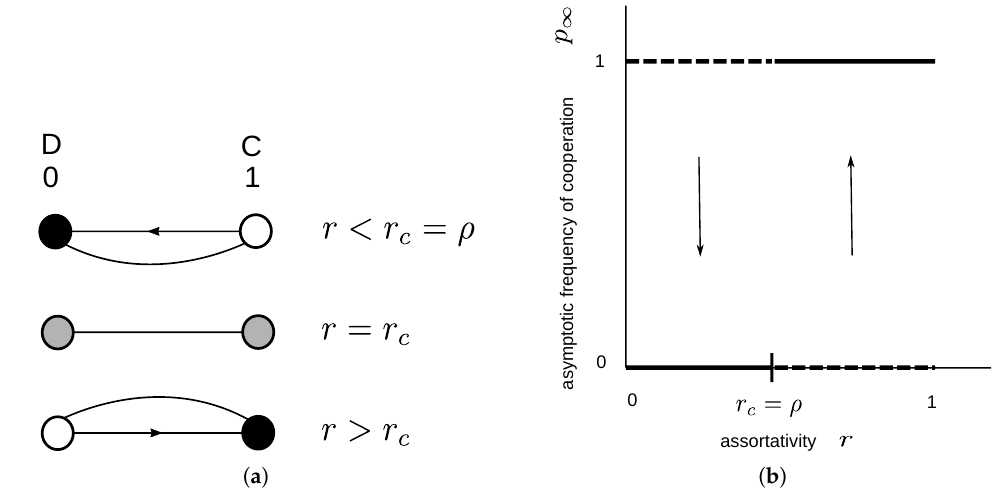
Figure 1. Phase line diagrams and the bifurcation diagram for the donation game with assortative interactions. ( a ) In the phase line diagrams closed circles represent stable equilibrium points, open circles represent unstable equilibrium points, and the curved line connecting equilibrium points indicates the graph of the function on the right-hand side of the r -replicator equation. ( b ) In the bifurcation diagram solid lines represent stable equilibrium points, dashed lines represent unstable equilibrium points, and arrows indicate the direction of evolutionary